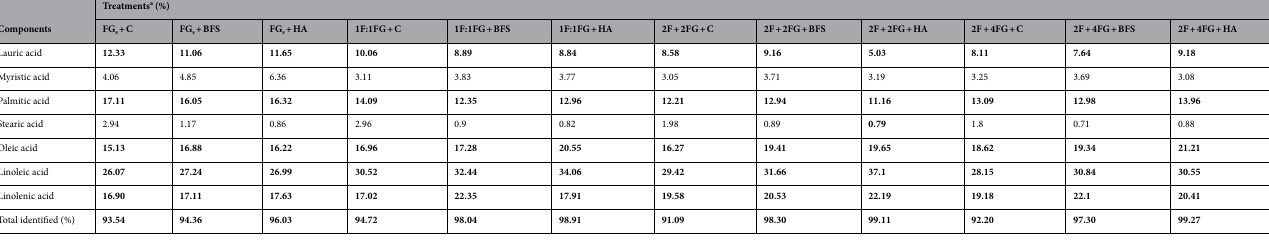
Table 7. Proportion of fenugreek oil constituents under different cropping patterns and fertilization. The main components are shown in bold. a C (control), BFS (biofertilizers), HA (humic acid), and FGs (fenugreek sole cropping), 1F:2FG, 2F:2FG, and 2F:4FG are the ratios of fennel and fenugreek in the intercropping patterns.